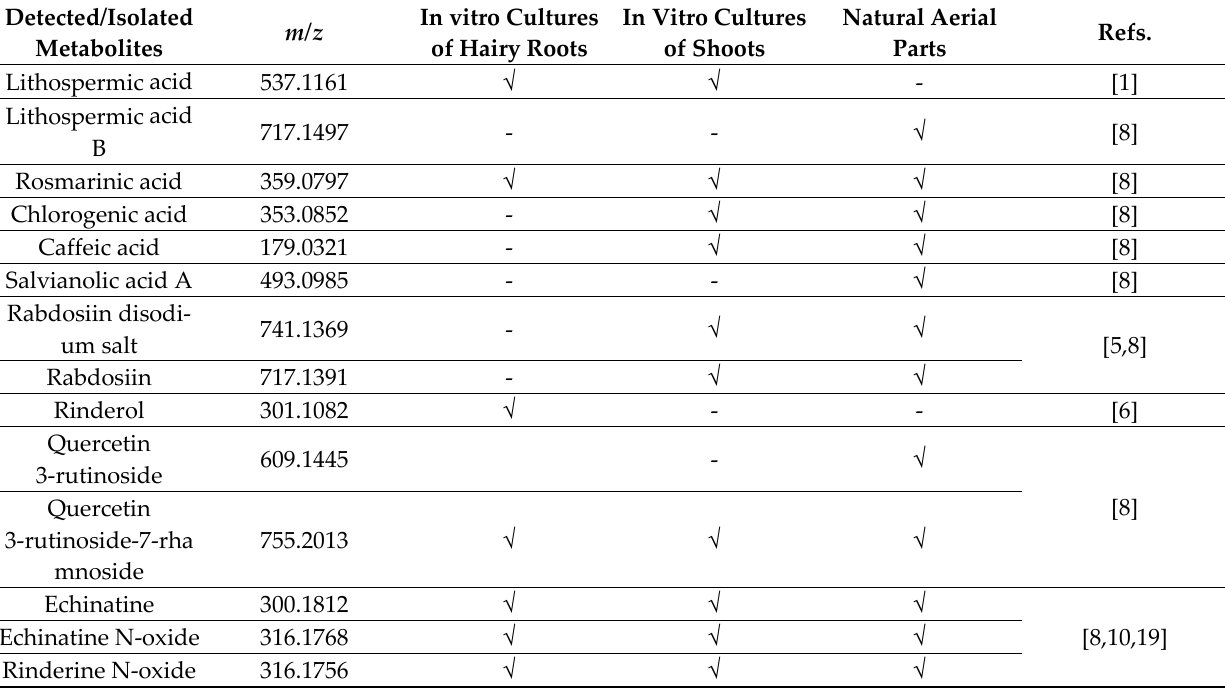
Table 1. Comparison of the chemical analyses between in vitro cultures of hairy root in vitro cultures of shoots and aerial parts of the plant in nature.